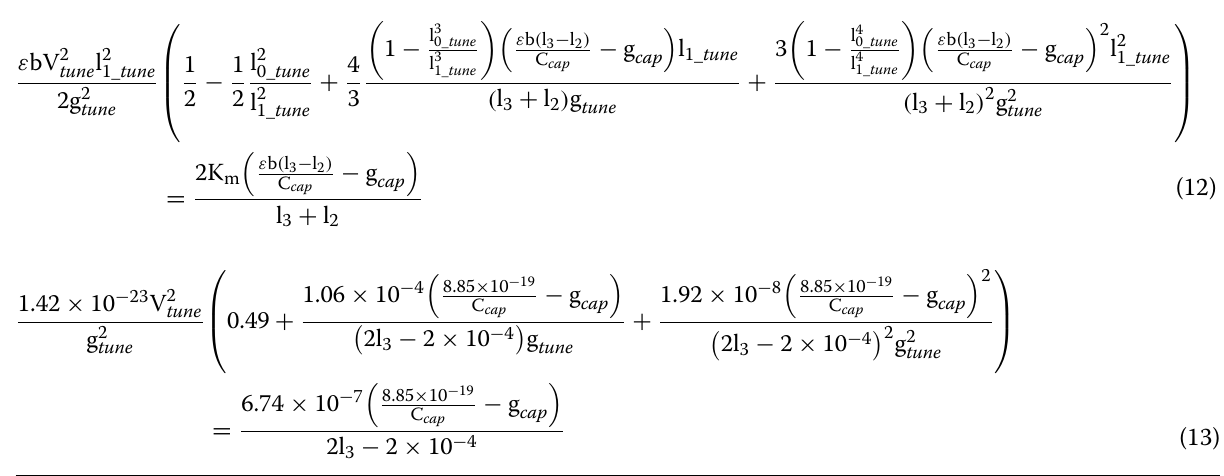
Figure 11a represents the calculated result of the pro- posed capacitor’s C – V response using the model in the ‘design of the structural parameters’ section and the meas- ured result. By adding the parasitic capacitance compo- nent on the capacitor plate and the tuning electrode, those two values are well matched as shown in Fig. 11b. To com- pensate the initial capacitance (value at V tune 0 V), the = structural parameter, b was increased by 45 μm represent- ing the parasitic capacitance. In terms of the tuning plate, since there exists two triangle shaped stopper at the end of the plate, the attractive force between the tuning plate and the tuning electrode is increased due to the increased parasitic capacitance. Therefore, we increased l 1_tune by 6.5 μm. Although this modification is well matched in the initial and the end of the tuning region, there is still a mis- matched region in the middle. We consider this is because the levering beam sinks down a little when the control and the tuning voltages are applied simultaneously, which is not included in the